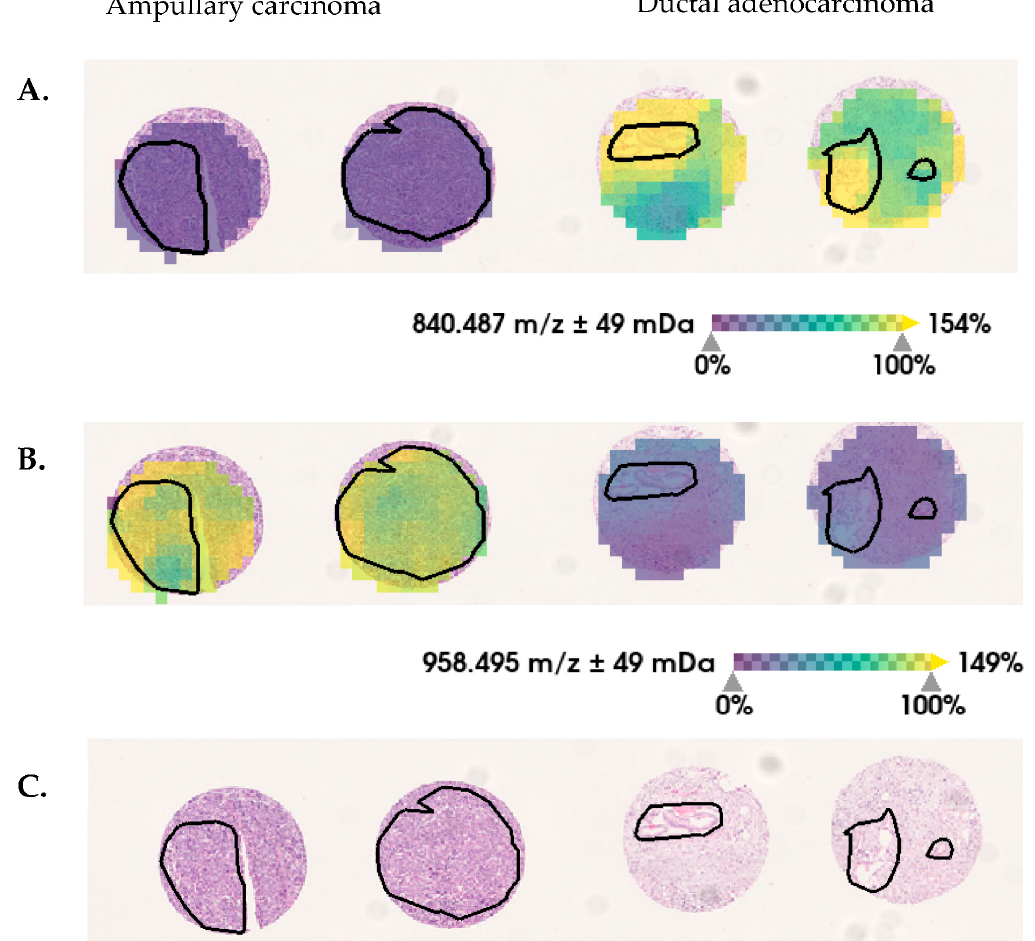
Figure 3. Selected discriminative m/z values between ductal-adenocarcinoma and ampullary-carcinoma pancreatic tumor tissue. In tumor regions (black lines), the relative intensity distribution of ( A ) m/z 840 Da are decreased and ( B ) m/z 958 Da are increased in ampullary carcinoma, in comparison with ductal adenocarcinoma. ( C ) Hematoxylin and eosin (H&E) staining is shown, for orienta- tion.